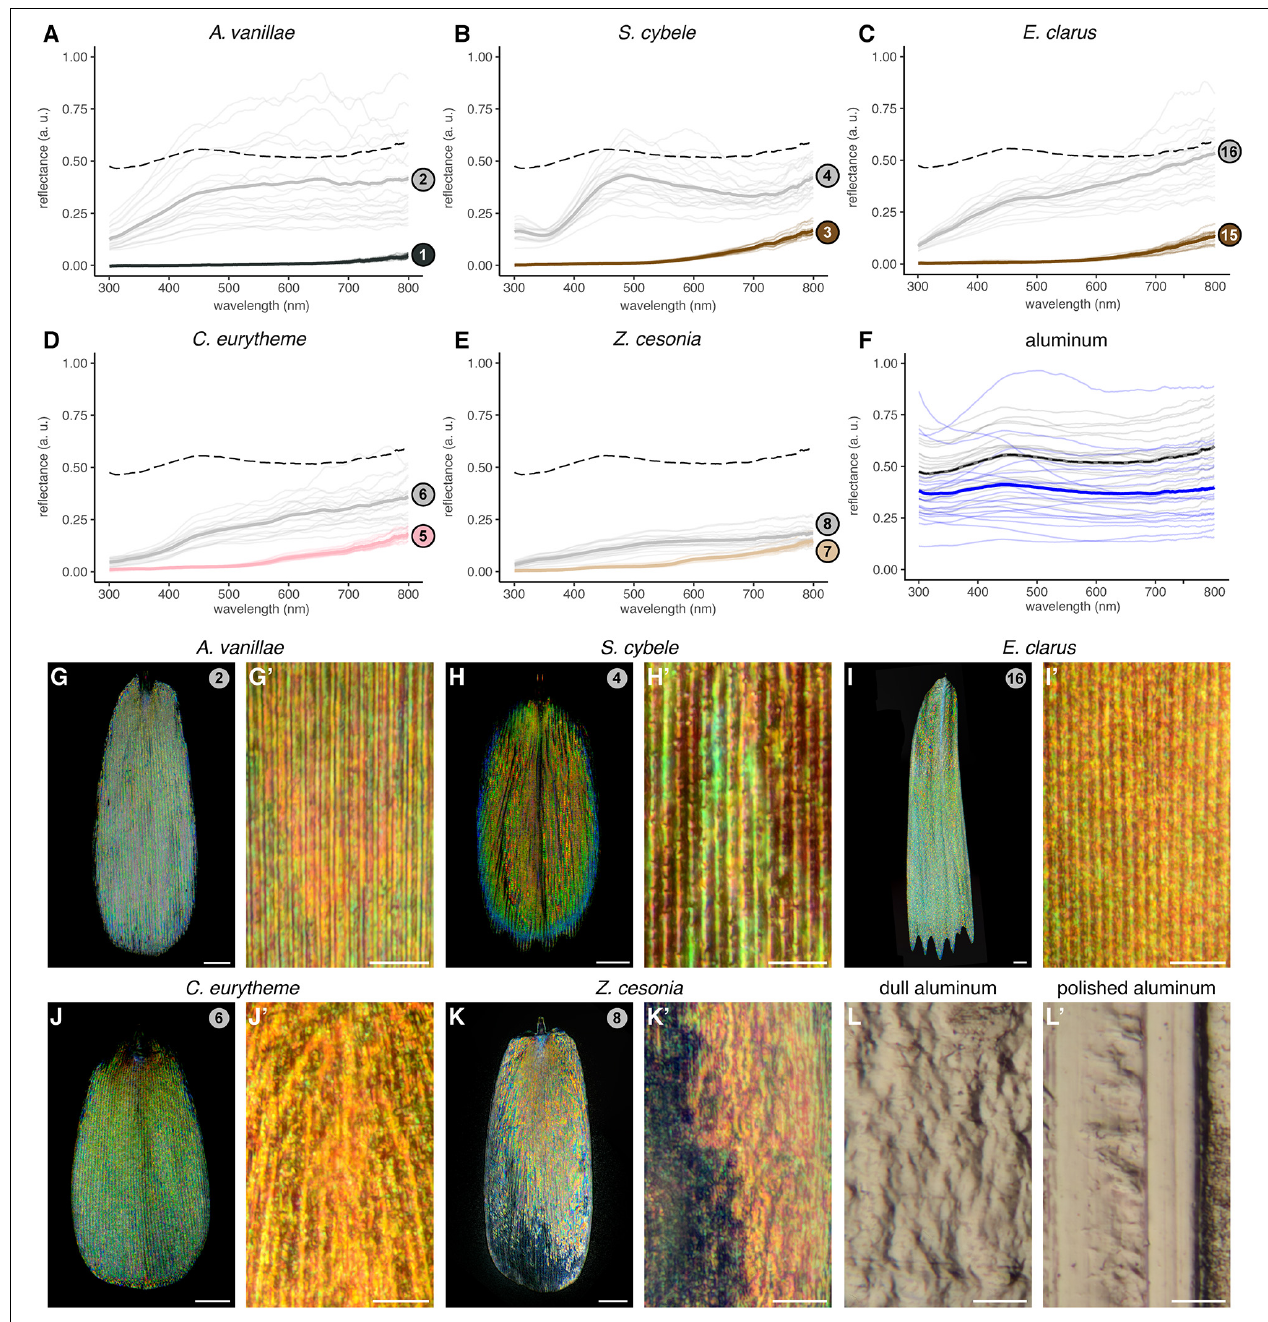
FIGURE 4 | Silver broadband reflectance resulting from densely intermixed colored reflections. (A–E) Reflectance spectra of silver pattern elements (gray lines), compared to adjacent arrays of non-reflective scales (black, brown, pink and beige lines). Faded lines represent individual measurements taken within the same wing surface. Dotted lines indicate the averaged spectra of polished aluminum foil for comparison. (F) Reflectance spectra of the polished side (gray) and dull side (blue) of aluminum foil. (G–K’) High-magnification reflected-light microscopy of single silver scales using a MPlanFLN 50 × lens (G–K) , and an LMPlan Achromatic 100 × lens (G’–K’) . (L,L’) High magnification reflected light microscopy of dull and polished sides of aluminum foil under the 100 × lens. Scale bars: (G–K) = 20 µ m; (G’–K’,L,L’) = 10 µ